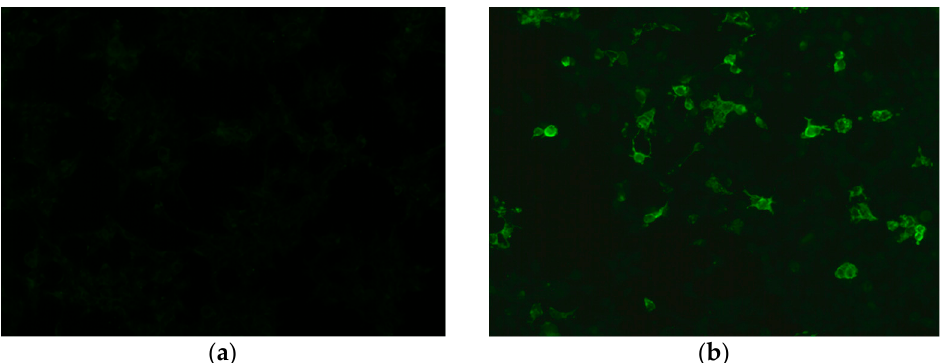
Figure 2. Detection of MOG IgG in a cell-based assay: ( a ) negative control stain; ( b ) positive MOG IgG reaction. Images from the collection of Division of Neurochemistry and Neuropathology, Poznan University of Medical Sciences.